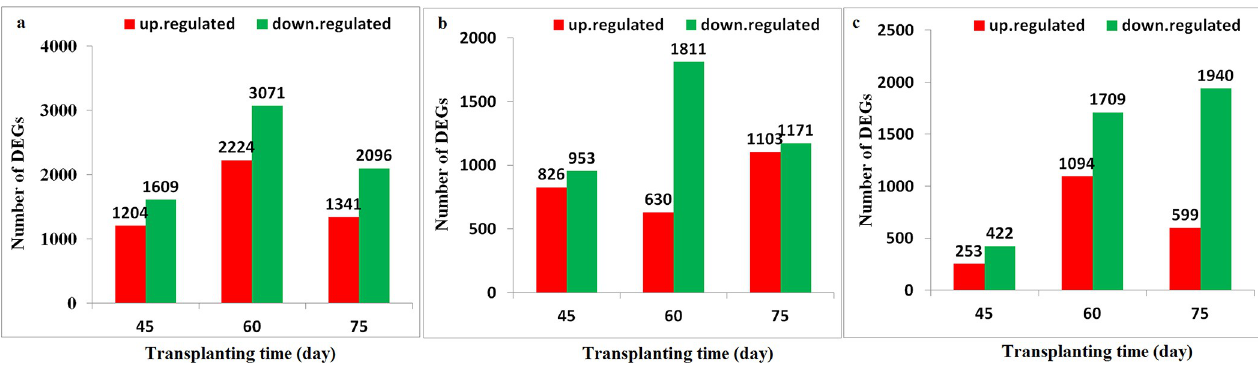
Fig 4. Number and distribution of up- and downregulated genes in the roots of S . miltiorrhiza after treatment with different N levels at 45, 60, and 75 days after transplanting (DAT). (a) N0 vs. Nf. (b) Nl vs. Nf. (c) N0 vs.Nl.